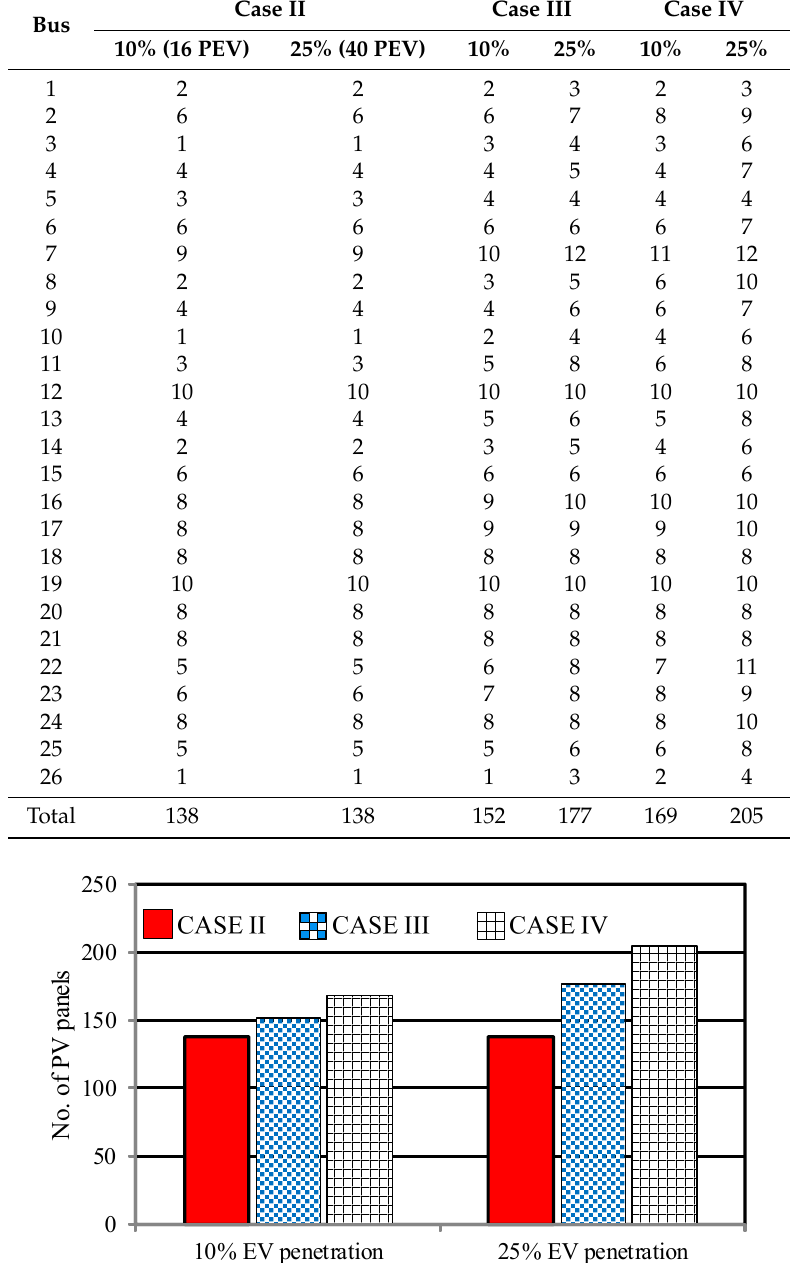
Figure 7. Number of PV panels in different cases.